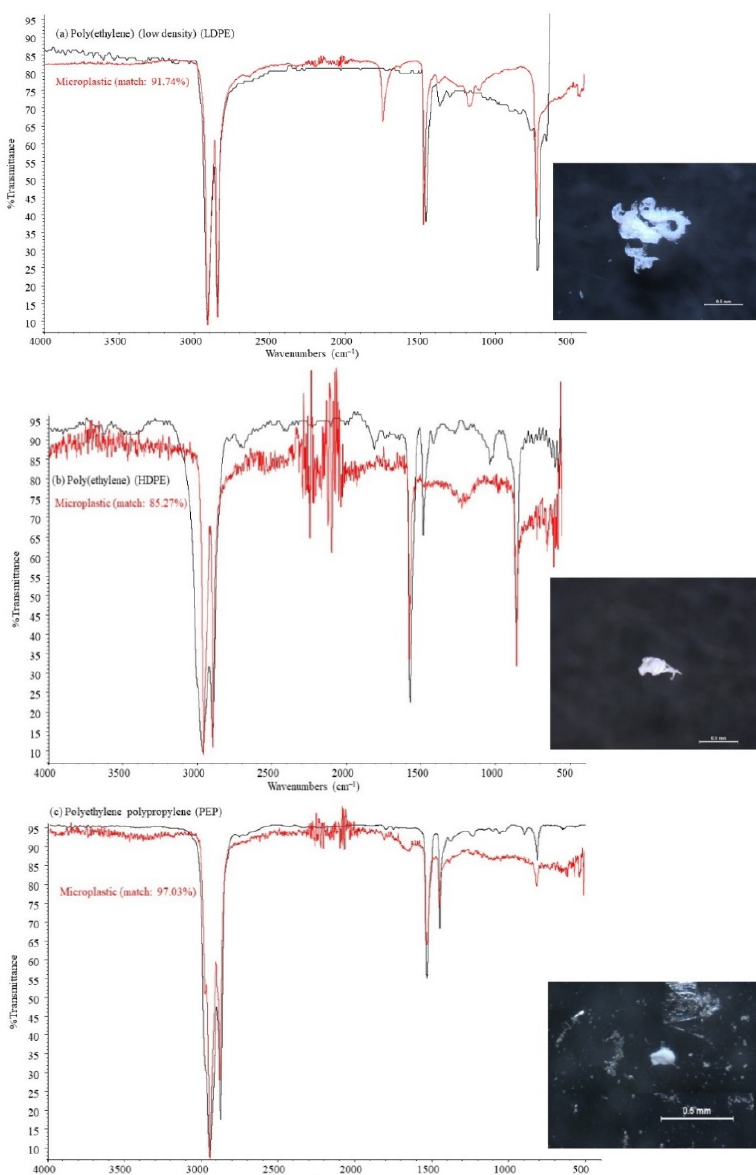
Figure 4. FTIR standard spectra (black lines) and microplastic samples (red lines) for: ( a ) low-density polyethylene (LDPE); ( b ) high-density polyethylene (HDPE); and ( c ) polyethylene polypropylene (PEP).